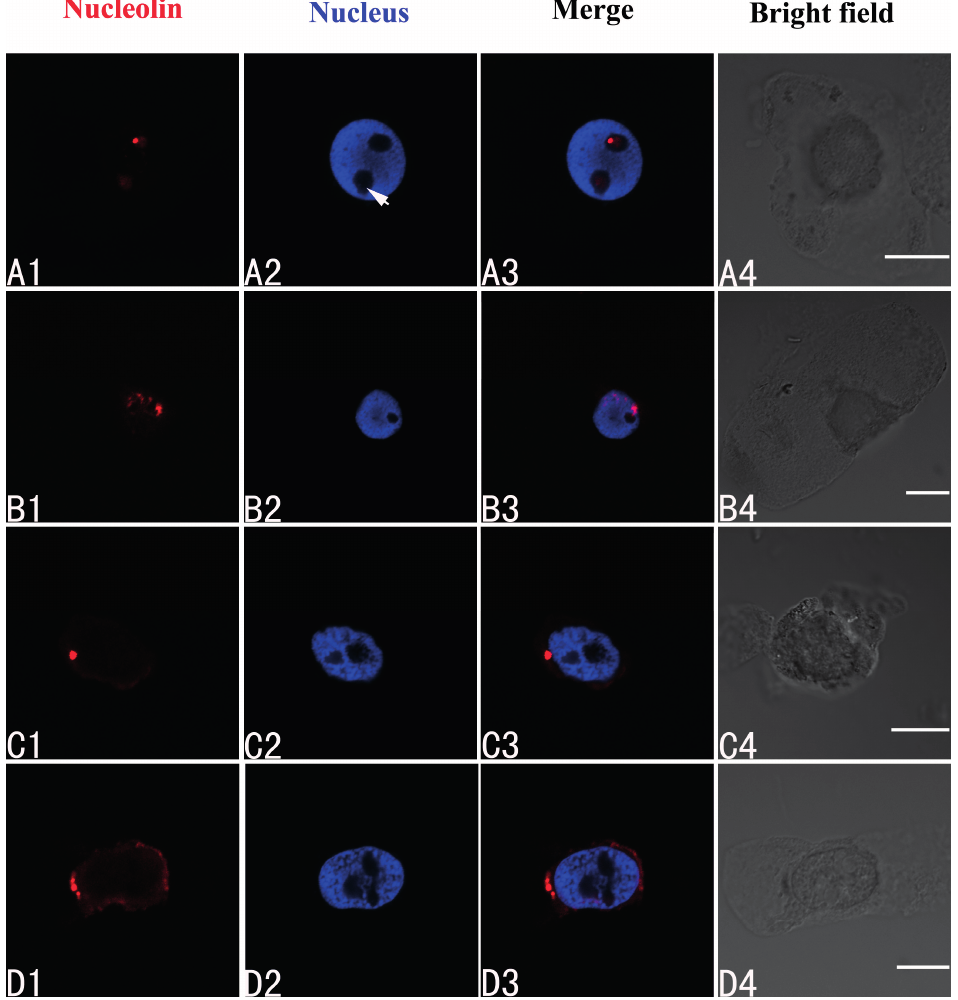
Figure 5. Simultaneous detection of nucleolin after incubation with primary anti-nucleolin antibody and secondary antibody conjugated with TRITC (Tetramethylrhodamine isothiocyanate) (red), and of DNA after incubation with DAPI (blue) in the same single optical section using confocal microscopy. ( A1 , B1 , C1 , D1 ) Nucleolin detection; ( A2 , B2 , C2 , D2 ) DNA detection; ( A3 , B3 , C3 , D3 ) Merged image of “nucleolin detection” and “DNA detection”; ( A4 , B4 , C4 , D4 ) bright field image. ( A1 – A4 ) Nucleolin in nucleolus of control cells; ( B1 – B4 ) The migration of nucleolin from the nucleolus to the nucleoplasm in cells treated with 100 μ M Pb for 24 h; ( C1 – C4 , D1 – D4 ) Nucleolin in the cytoplasm of cells treated with 100 μ M Pb for 48 h ( C1 – C4 ) and 72 h ( D1 – D4 ). Scale bars = 10 μ m. Arrowhead shows